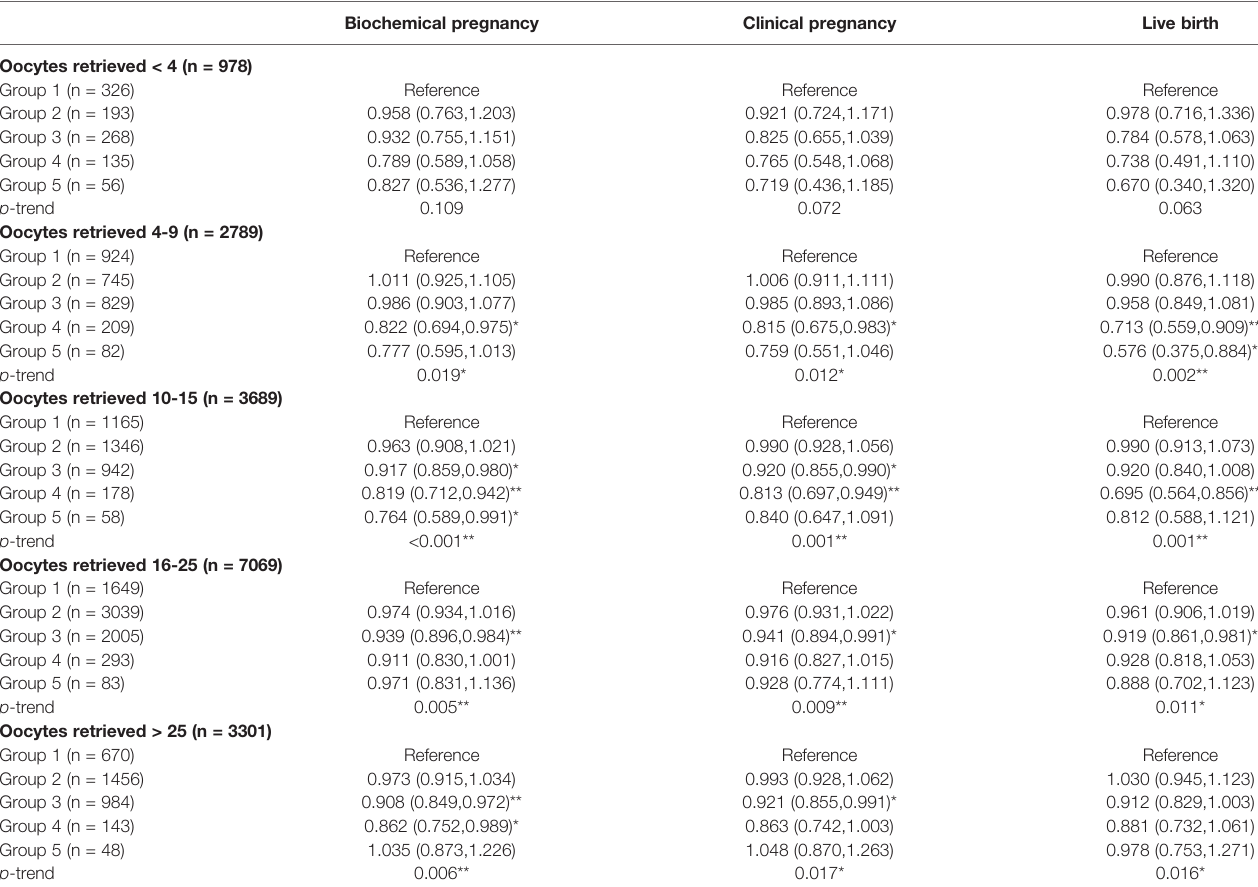
TABLE 5 | The results of strati fi cation analyses assessing the associations between cryopreservation time and pregnancy outcomes based on the number of oocytes retrieved. Biochemical pregnancy Clinical pregnancy Live birth Oocytes retrieved < 4 (n = 978) Group 1 (n =